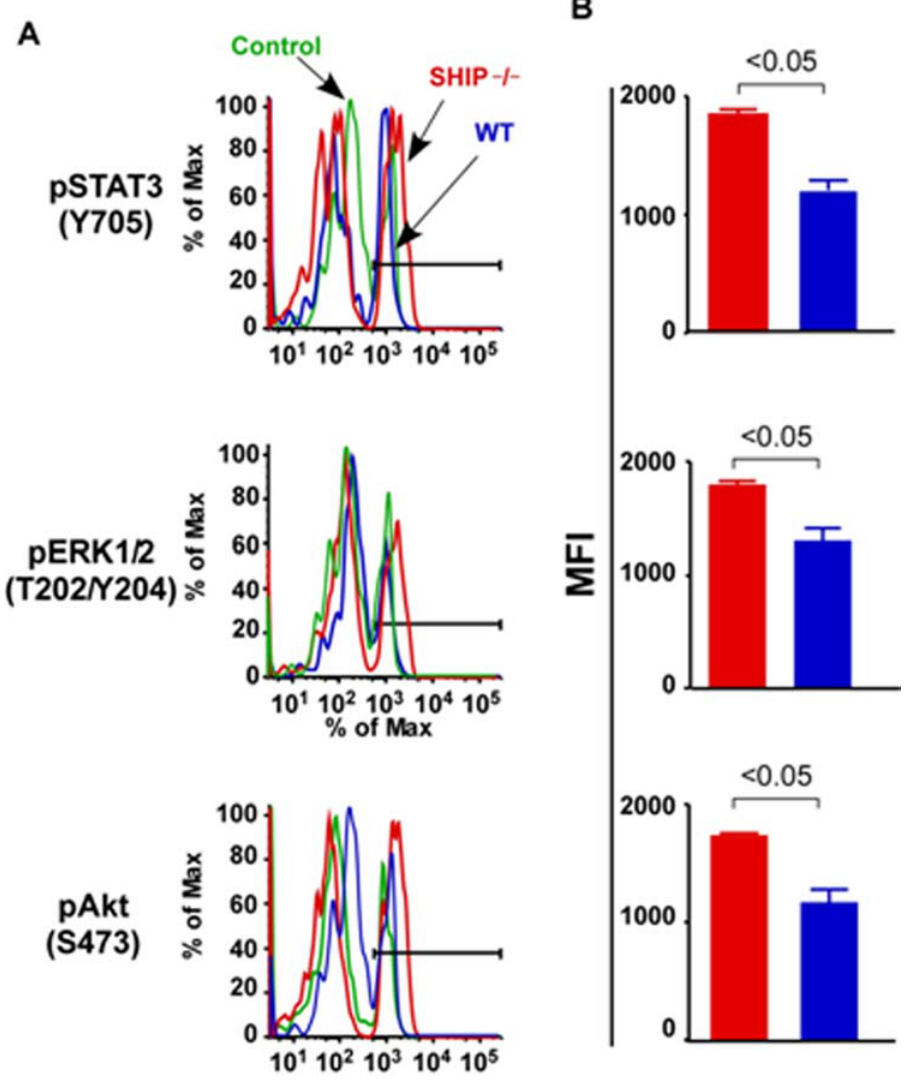
Figure 5. Increased phosphorylation of signaling proteins in SHIP 2 / 2 MKP in BM. (A) Histogram representing the level of phospho-STAT3, phospho-Erk1/2 and phospho-Akt in Lin 2 c-kit + CD41 + BM cells isolated from SHIP 2 / 2 (black line) and WT (gray line) mice. Isotype antibody control indicated on the histogram. (B) Represented is the mean 6 SEM of the mean fluorescence (MFI) intensity of phospho-STAT3, phospho-Erk1/2 and phospho-Akt on SHIP 2 / 2 ( 2 / 2 ) (n=4) and WT (n=4) Lin 2 c-kit + CD41 + in BM. Significance was established using the Mann-Whitney test. p values indicated on each graph.